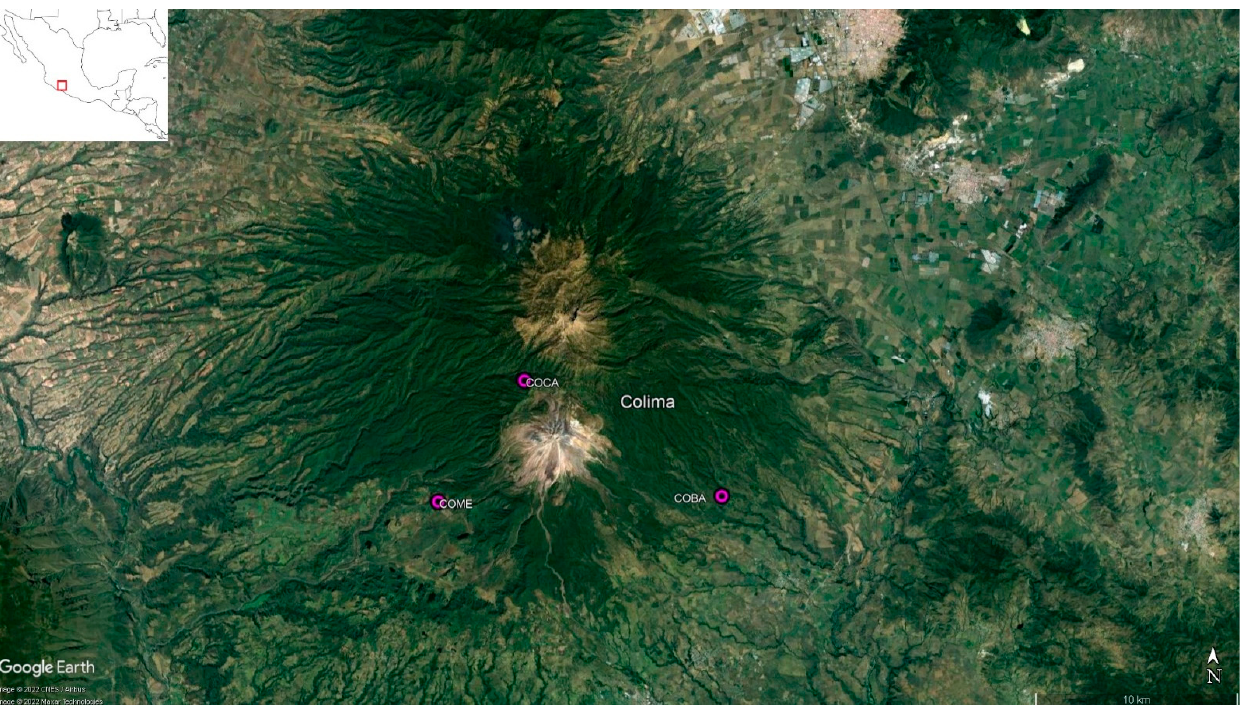
Figure 2. Map of Colima volcano with the seismic stations (magenta circles) (map data ©2021 Google).